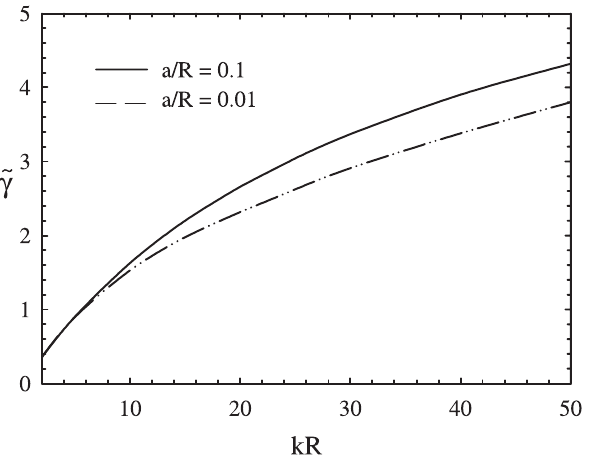
Fig. 4. Normalized instability growth rate as a function of kR for the model profile of the magnetic field. Different curves correspond to different values of a/R = 0 . 1 ; 0 . 01.